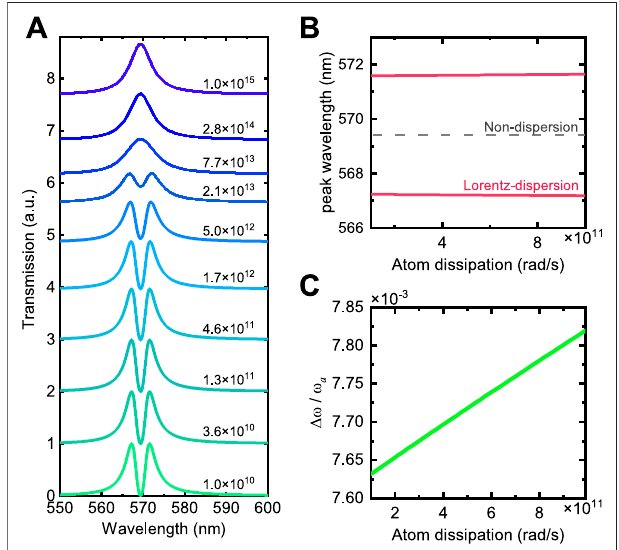
FIGURE 4 | The change of transmission peaks under the change of atom dissipation. (A) Transmission spectrum in Lorentz-dispersion changed byatomdissipation γ (thenumbernexttoeachcurve).As γ increased,thetwo peaks reduce and ultimately disappears. (B) The position of transmission peaks. Two peaks in Lorentz-dispersion (red solid line) surround the one peaks in non-dispersion (gray dotted line) which is not vary as atom dissipation. (C) The relative splitting degree Δω / ω a increased as transmission of fi lm